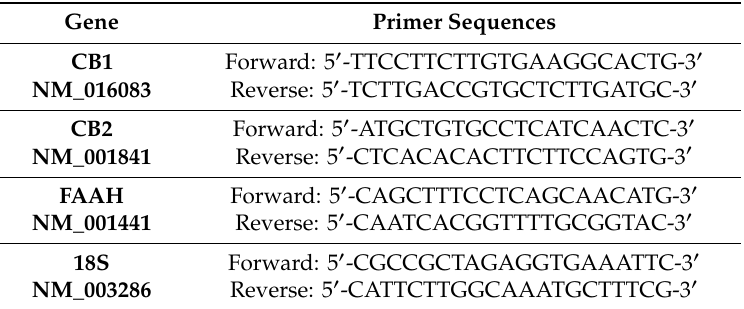
Table 1. Sequences of the primers used in RT-PCR